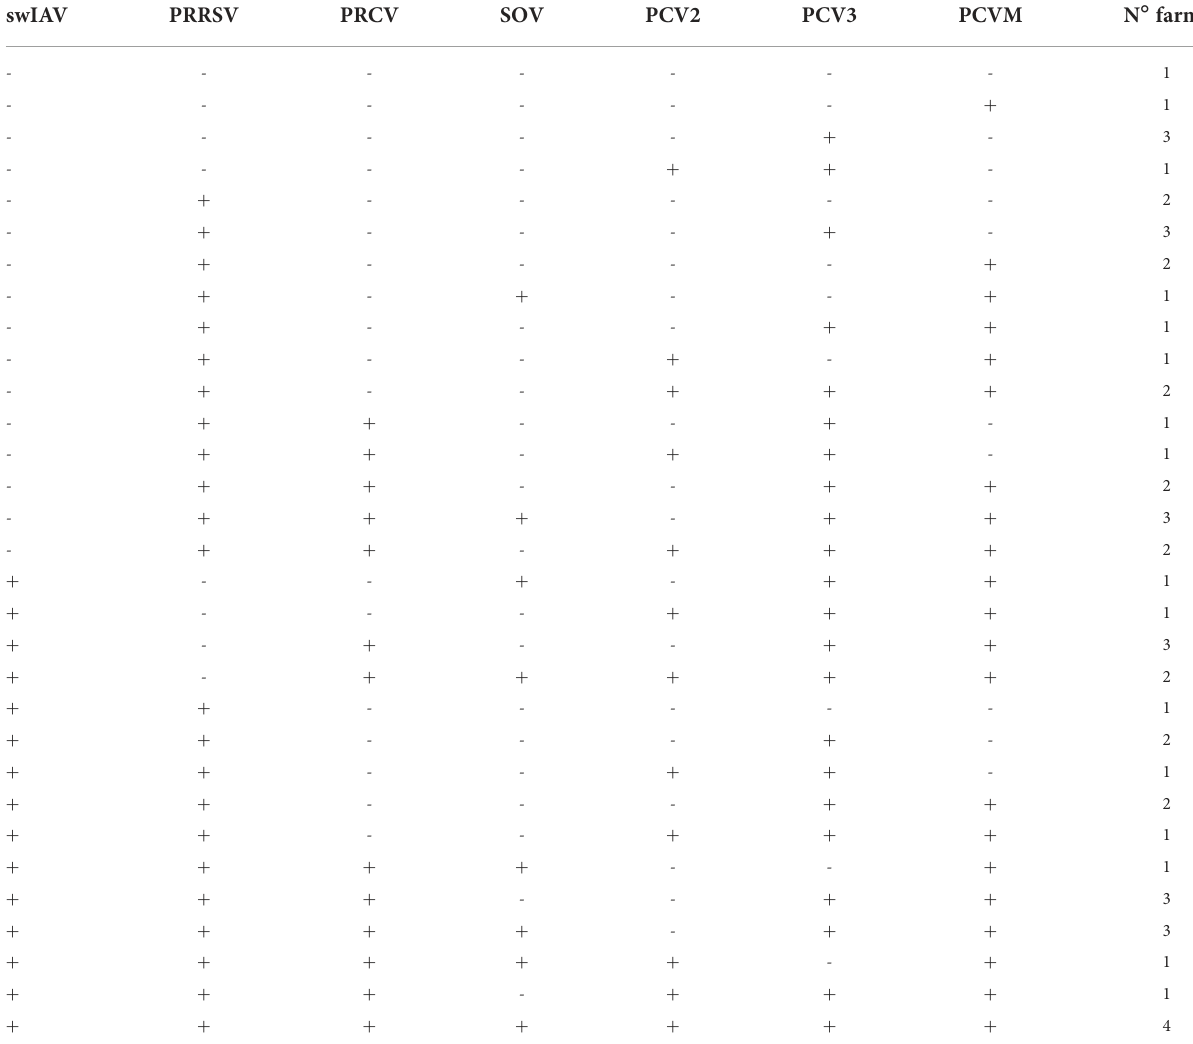
TABLE 2 Distribution of the 55 examined farms according to the combination of respiratory viruses found in the nurseries. swIAV PRRSV